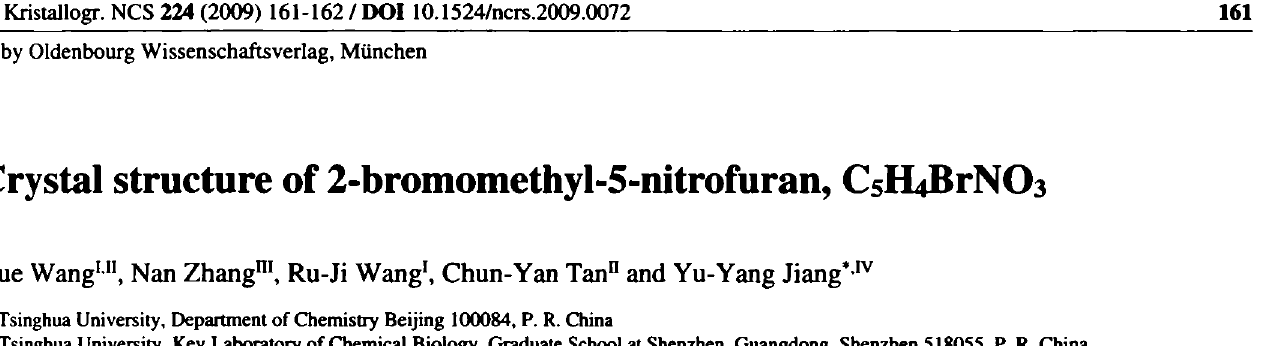
Table 1. Data collection and handling.